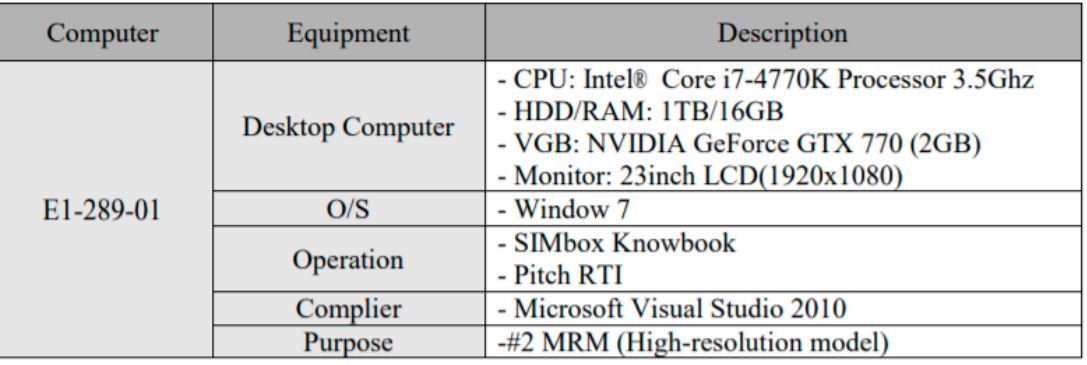
Figure 12. Operation environment for MRM (high-resolution simulation).